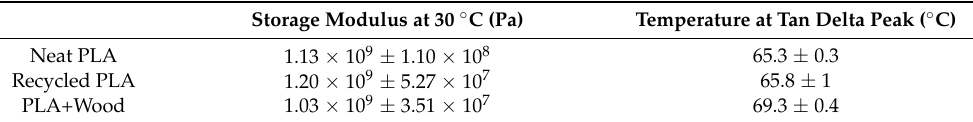
Table 7. Storage modulus at 30 ◦ C and glass transition temperature by